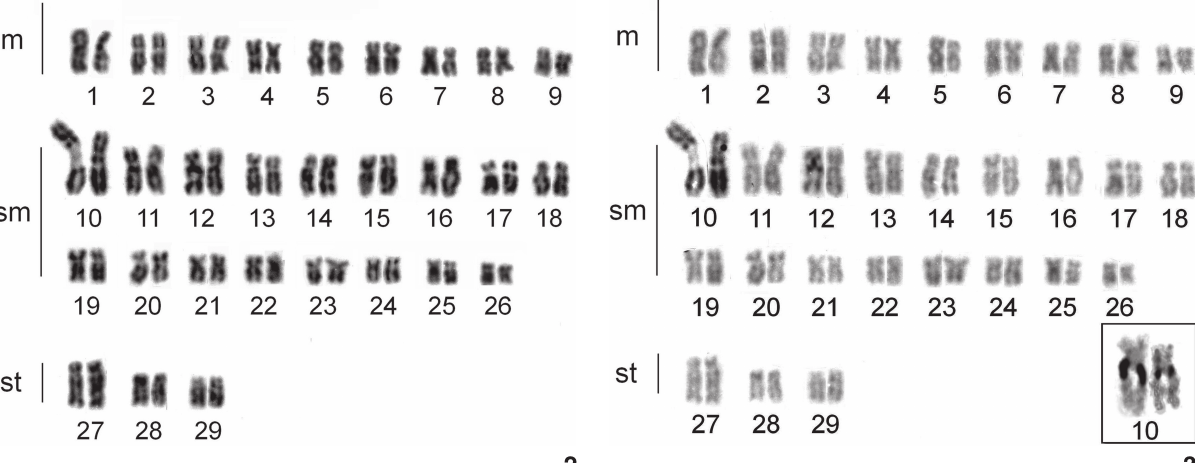
Figures 2-3. Karyotypes of Imparfinis schubarti : (2) Giemsa stain and (3) C-band. In the box, interstitial Ag-NOR in the largest chromo- some